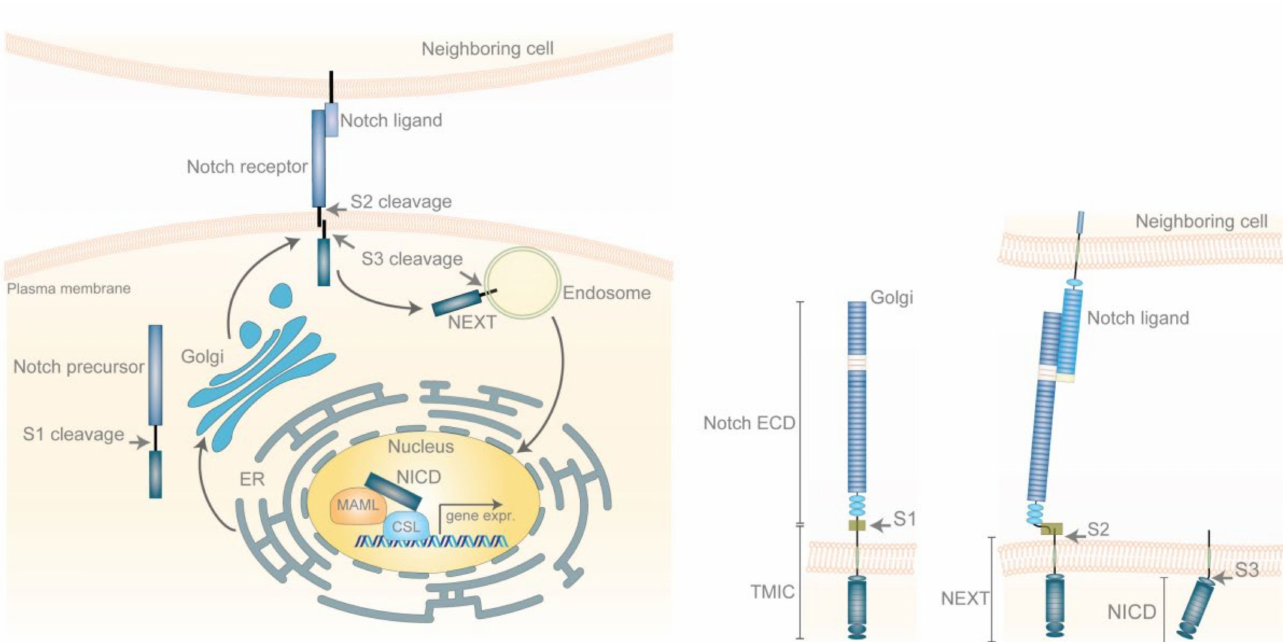
Figure 1. The Notch signaling pathway. To the left, a schematic representation of the routing of the Notch receptor in the signal-receiving cell is depicted. The Notch receptor is produced in the ER and undergoes S1-cleavage in the Golgi compartment. Following interaction with Notch ligand (Jagged or Dll ligand) presented on the neighboring, signal-sending cell, the Notch receptor undergoes S2- cleavage. S3-cleavage is then executed at the plasma membrane or in endosomes, and the Notch ICD is released and transported to the cell nucleus. In the cell nucleus, Notch ICD forms a ternary complex with the DNA-binding protein CSL and MAML, and the ternary complex regulates expression of specific genes, such as Hes or Hey . To the right, the various processing steps of the Notch receptor are described. S1-cleavage generates a Notch extracellular domain (Notch ECD), which is shedded, and a transmembrane and intracellular domain (TMIC) moiety. TMIC then undergoes S2-cleavage to generate the shorter Notch extracellular truncation (NEXT) moiety, which still spans the membrane. NEXT is finally cleaved by the γ -secretase complex (S3-cleavage), generating Notch ICD, which translocates to the